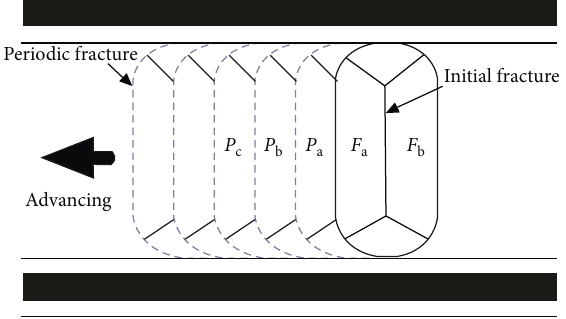
Figure 1: Typical geometry structure of the fractured roof